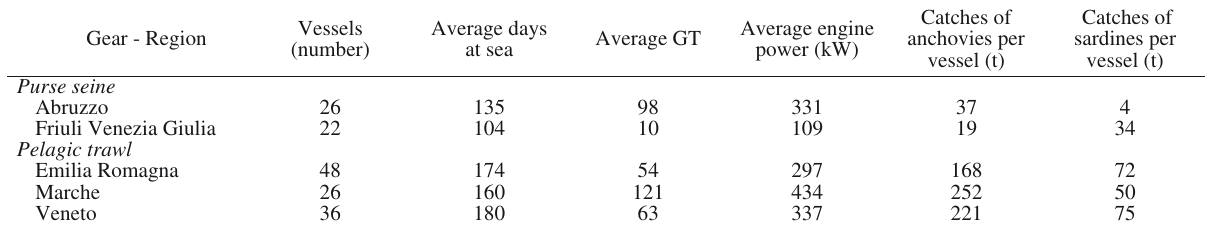
Table 1. – Average characteristics of the regional fleet and average catches per vessel. Source: IREPA, CNR-ISMAR.